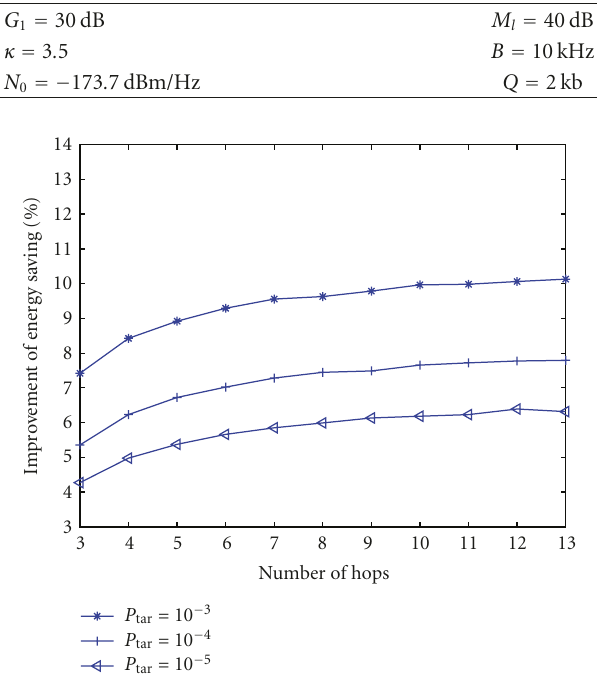
Figure 1: Average improved performance due to optimum BER allocations under di ff erent hop lengths for the loose delay